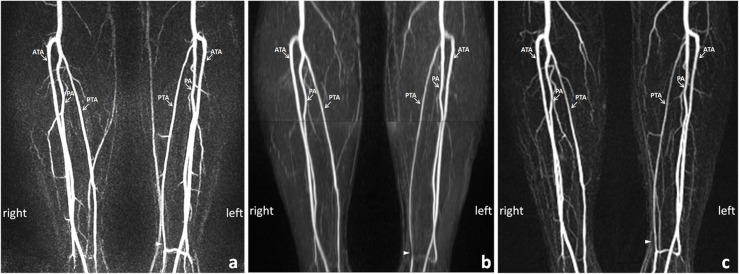
MIP images with the identical window level of FSD (a) and CE-MRA (c) of the calf arteries show no significant stenosis in the bilateral calf arteries in a 54-year-old woman with diabetes.Soft tissue artifacts and a false stenosis caused by signal loss are seen at the left distal peroneal artery (PA) (arrowhead) on the MIP image of QISS (b), of which the optimal window level is different from that of FSD and CE-MRA. MIP: maximum intensity projection; FSD: flow-sensitive dephasing; CE-MRA: contrast-enhanced MR angiography; QISS: quiescent-interval single-shot; ATA: anterior tibia artery; PTA: posterior tibia artery.